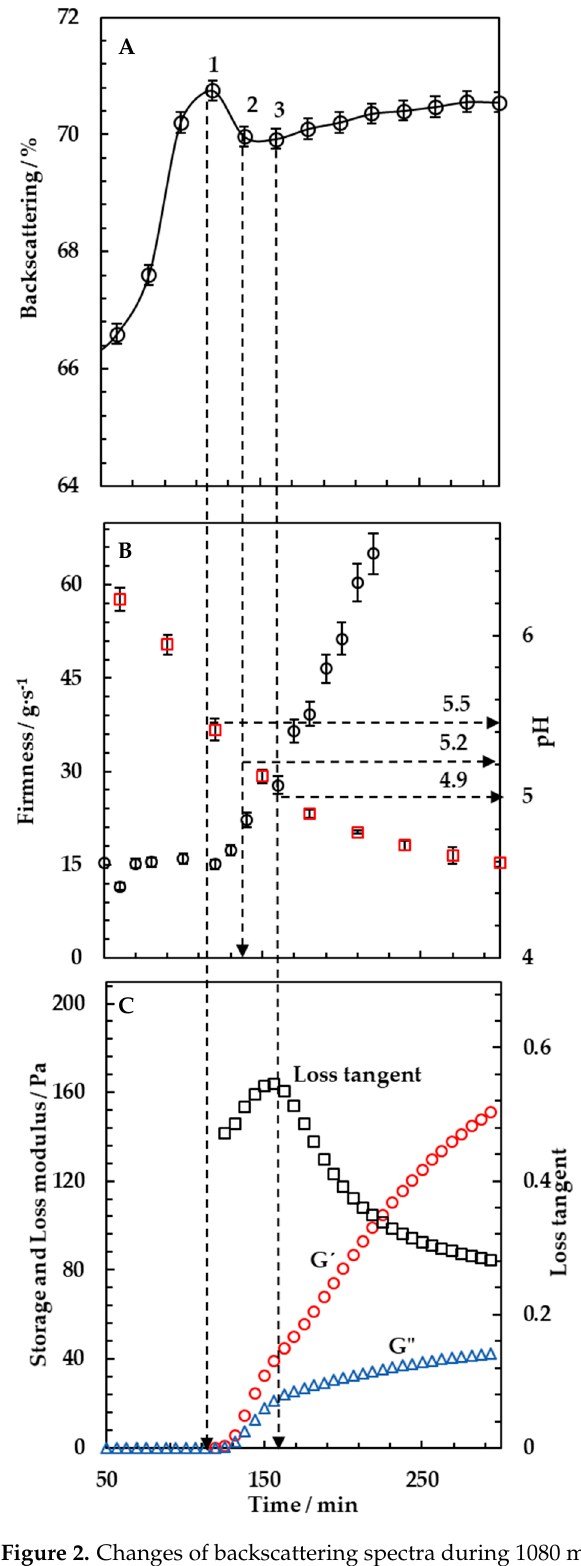
Figure 2. Changes of backscattering spectra during 1080 min measured in the middle height of the vial (20 mm), obtained from the analysis of backscattering data ( A ). Firmness, pH ( B ) and rheological properties ( C ) monitoring as a function of time for milk fermentation with 4.5% ( w/w ) of yogurt starter culture and an incubation temperature of 44 °C. Results are mean values of three replicates.